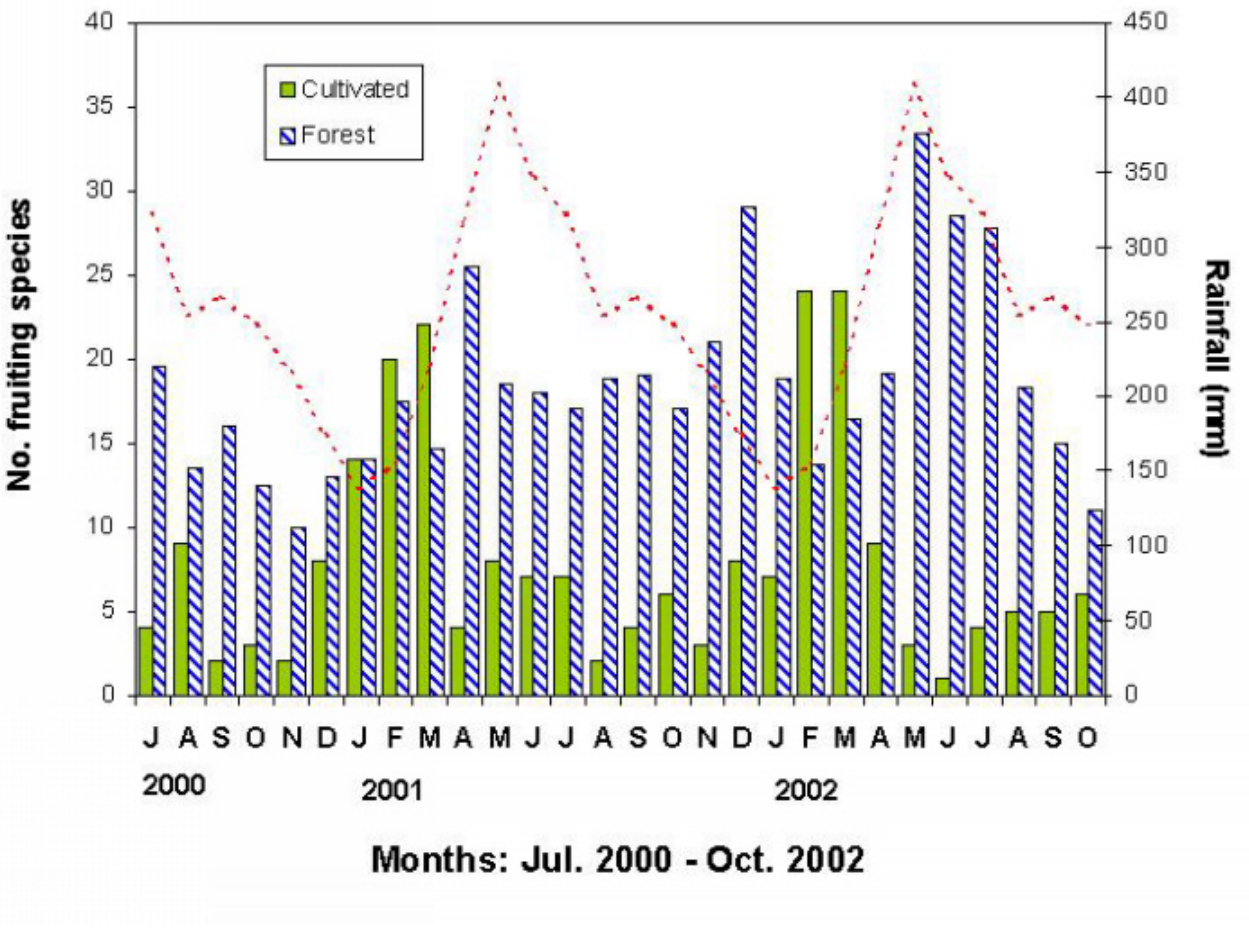
Fig. 4. Fruiting patterns of cultivated trees and the forest obtained from June 2000 to September 2002 (Parrado-Rosselli 2005), in the Middle Caquetá River region. Mean monthly precipitation (1979-1990; Duivenvoorden and Lips 1993) is represented by a broken